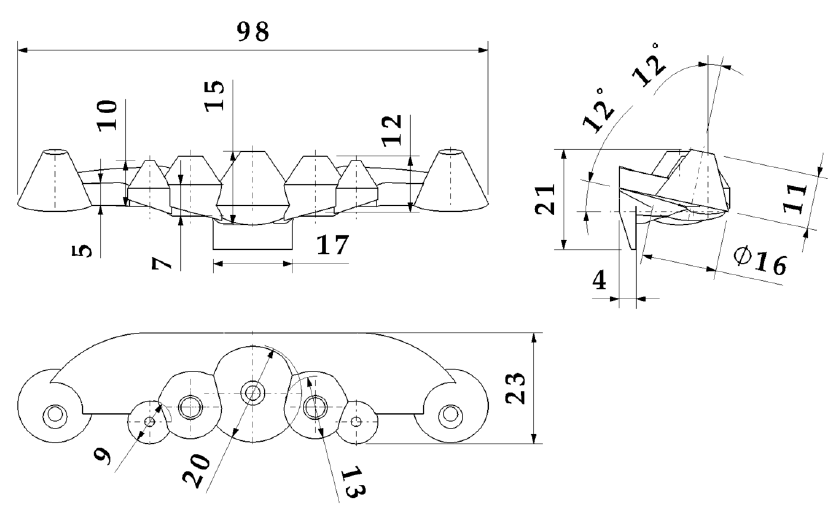
Figure 1. Collimating optical part.